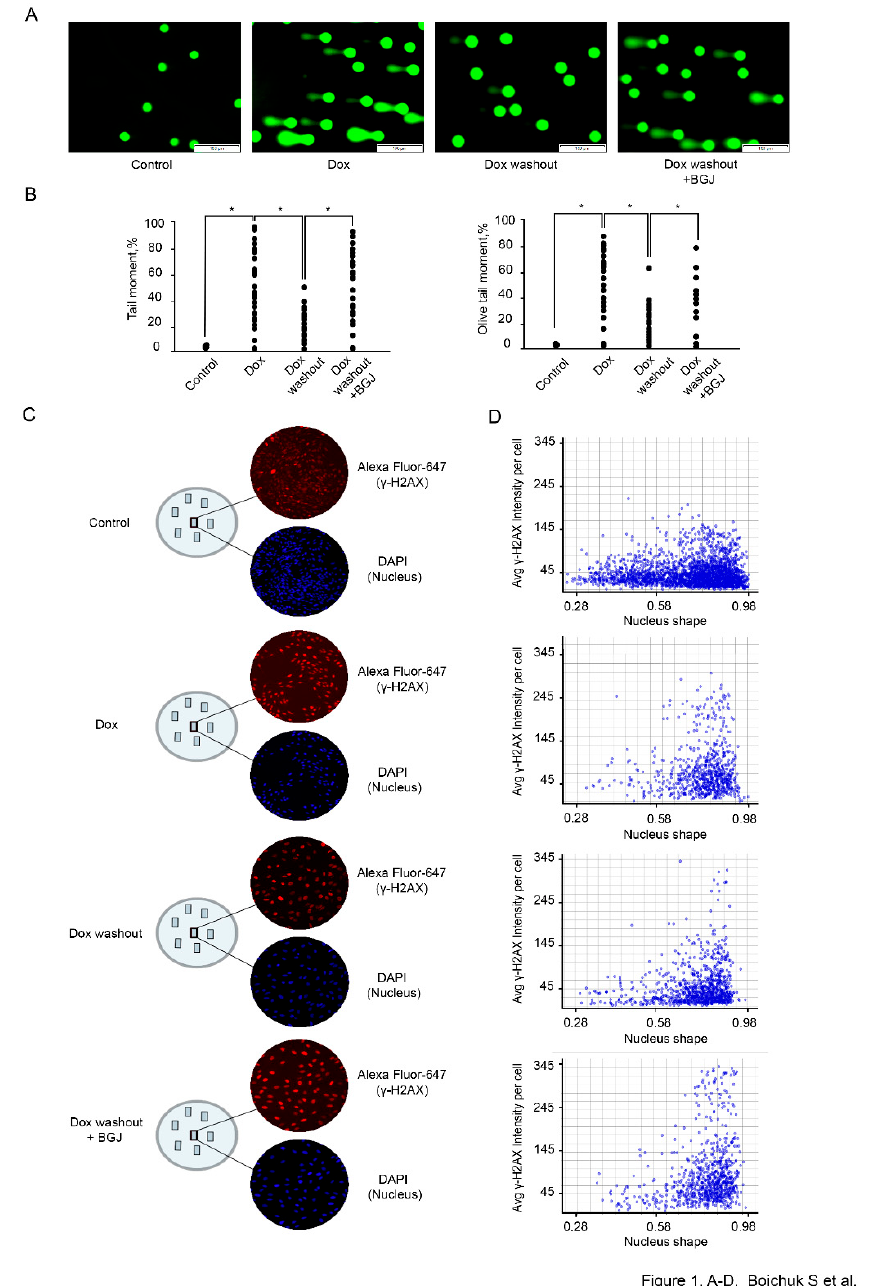
Figure 1. Inhibition of FGF-signaling delays the kinetics of γ -H2AX decline in doxorubicin-treated GIST cells. GIST T-1 cells treated with solvent (control) and doxorubicin (dox) 0.5 µ g / mL for 2 h following washout for 8 h and culture in the absence (Dox washout) and presence of BGJ398 (1 µ M), an FGFR1-4 inhibitor (Dox washout + BGJ398). ( A ) Representative images of comets from theWe added experimental settings indicated above (Scale bars = 100 µ m). ( B ) Graphic depiction of the calculated Tail Moment and Olive Tail Moment from analysis of alkaline Comet Assay shown in Figure 1A. Data is shown for a representative experiment, where at least 50 comets were quantitated for each experimental condition. ( C ) Cells were grown on slides for 24 h and treated with Dox and BGJ398 as indicated above. Cells were fixed and stained with DAPI (blue) and γ H2AX-specific antibody (red). γ H2AX-specific fluorescence intensity was measured for each nucleus (DAPI) and quantified automatically. ( D ) Histograms of γ -H2AX-specific fluorescence at the single-nucleus level. All images were acquired by GE Cytell imager as described in “Materials and